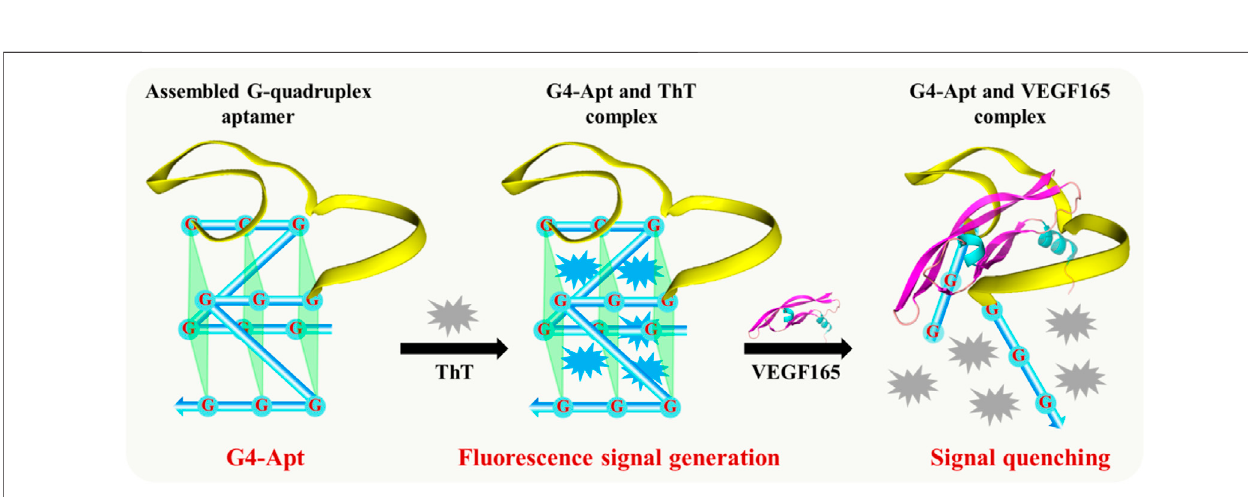
Frontiers in Bioengineering and Biotechnology |